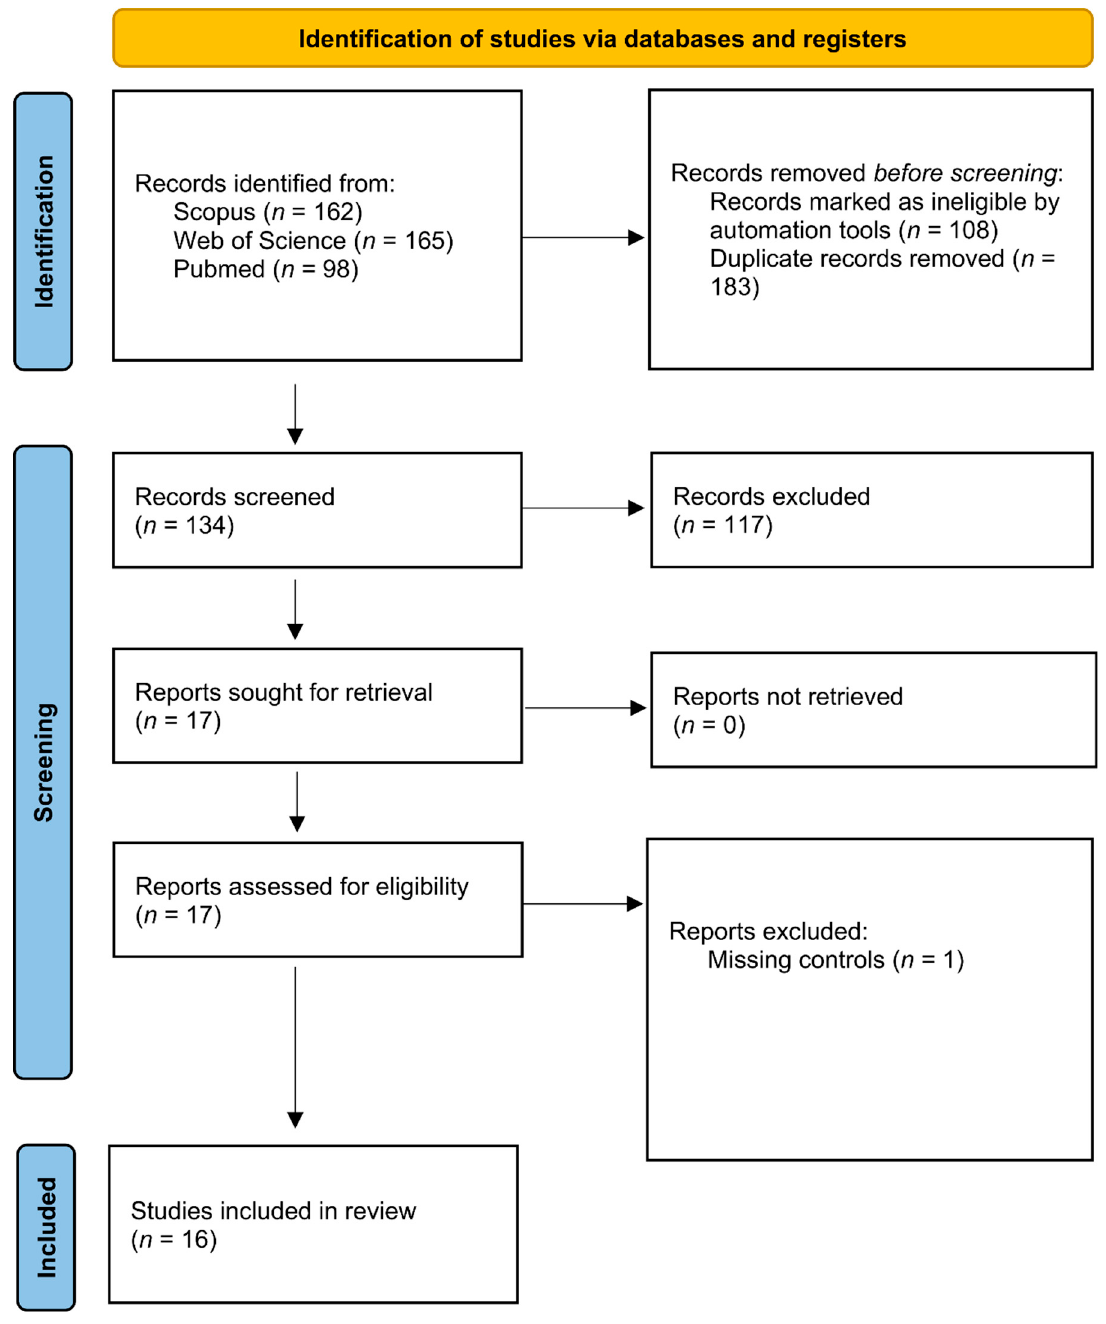
Figure 1. PRISMA flow diagram.